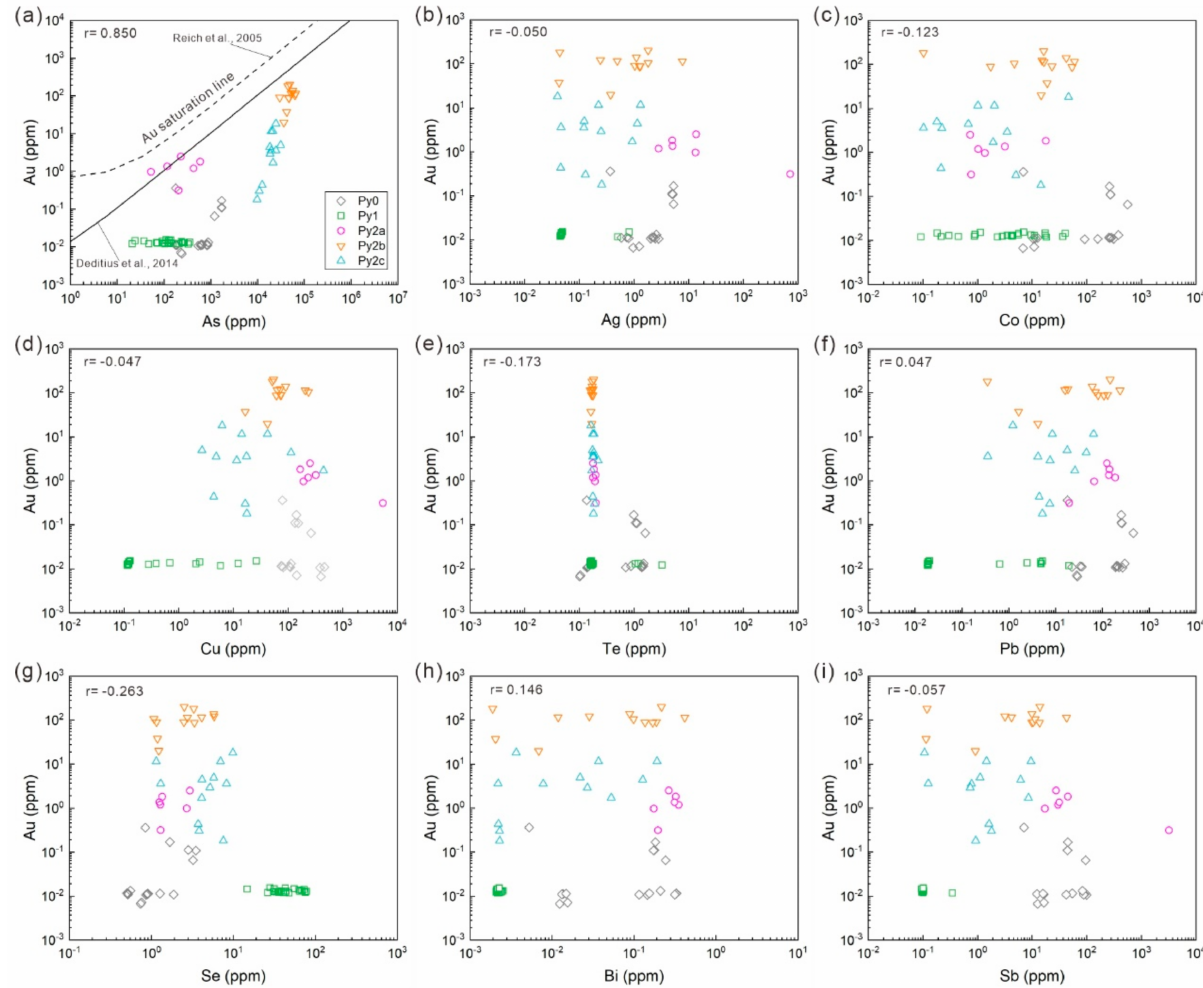
Figure 10. Binary plots and correlations between Au and other elements for different types of pyrite from the Dunbasitao gold deposit. In Figure 10a, the dashed line represents the Au saturation line for Carlin-type deposits [65], and the solid line represents that for orogenic gold deposits